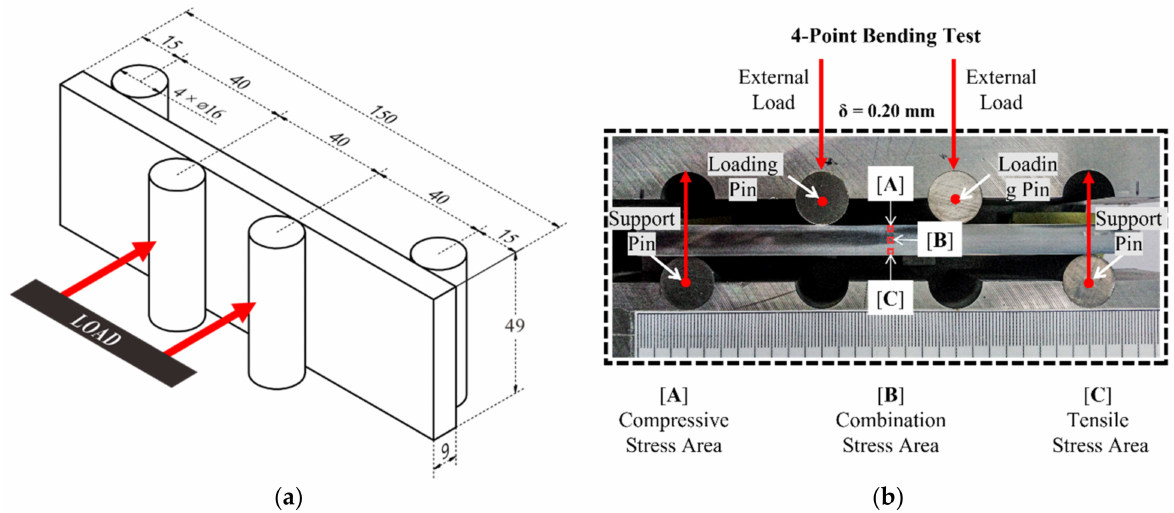
Figure 3. Experimental setup of 4-point bending test: ( a ) geometric view and ( b ) top view. The observation was conducted in compressive, tensile, and a combination of compressive and tensile stress